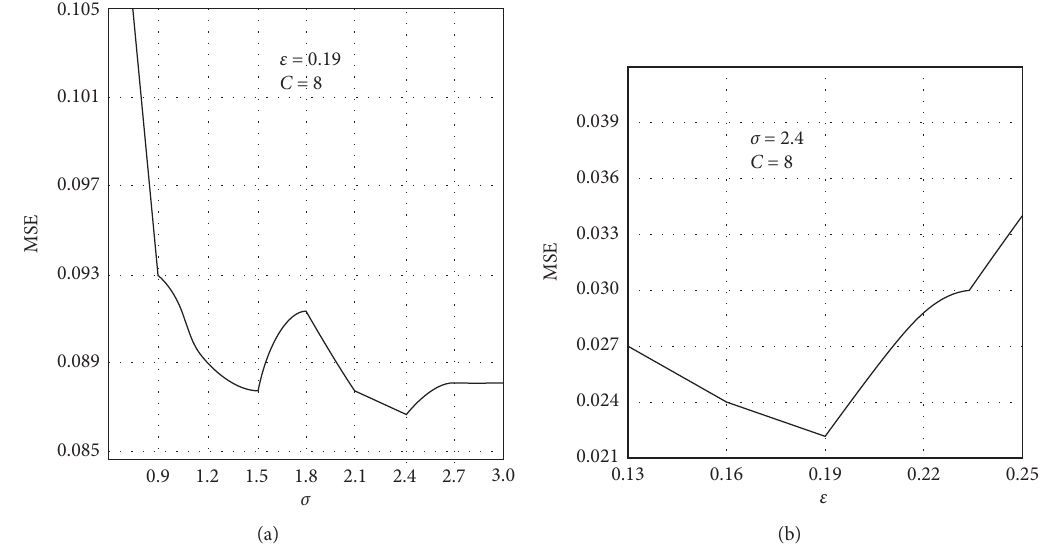
Figure 10: Effects of leave-one-out (LOO) technique in findings of kernel parameter σ (a) and parameter ε (b).